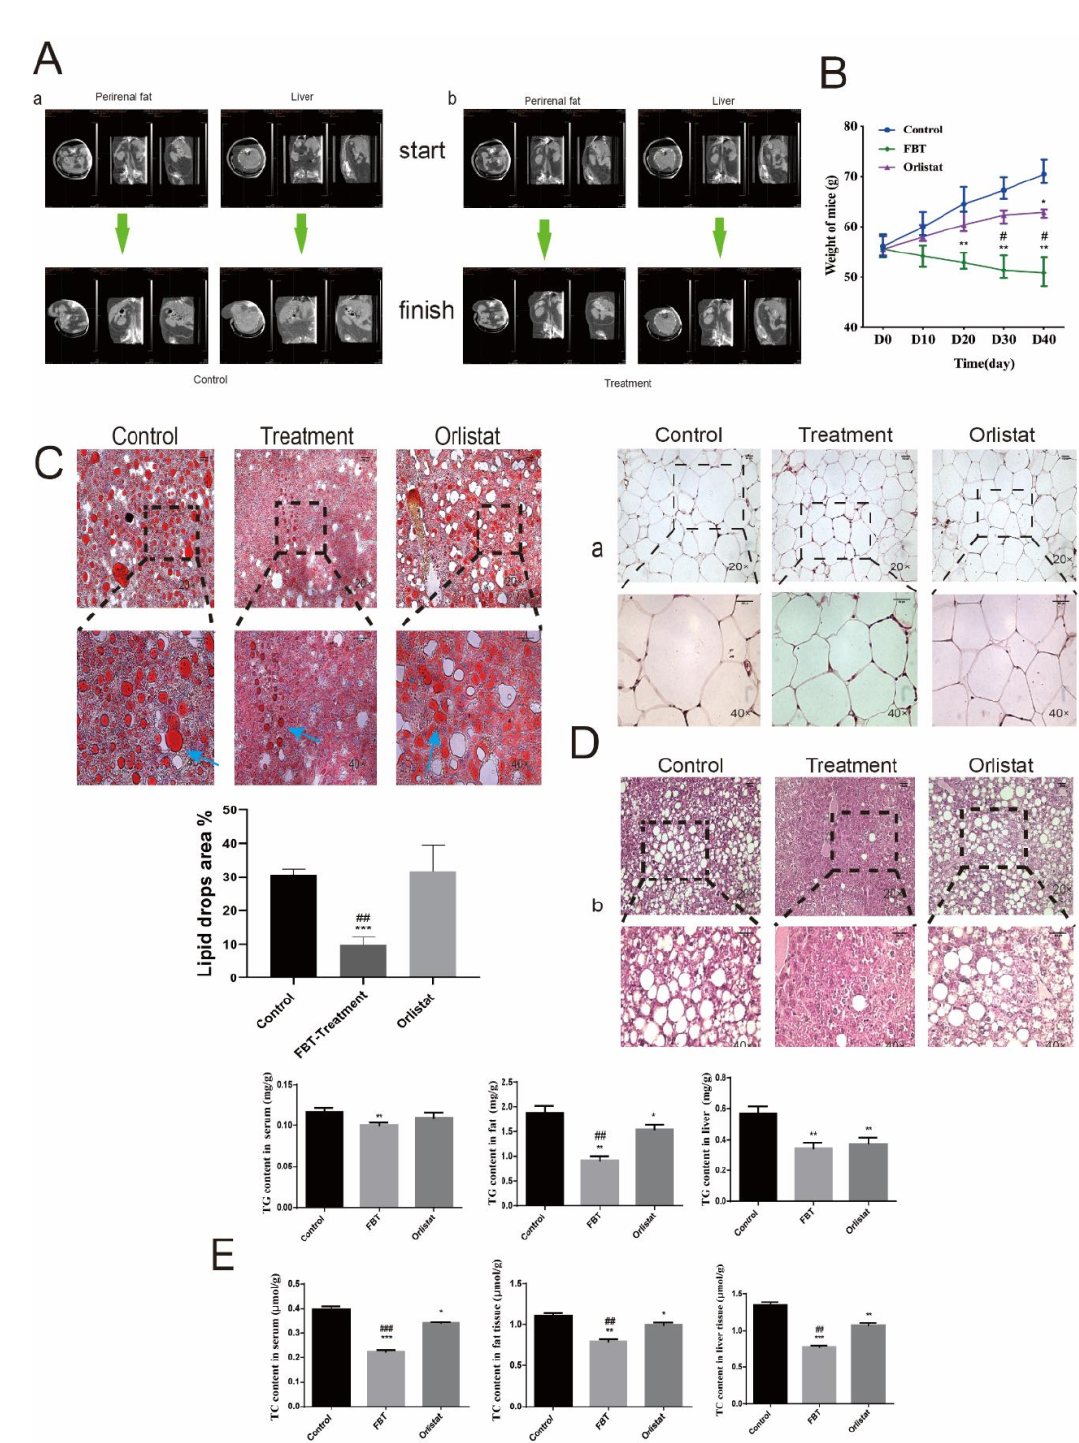
Figure 5. ( A ) Comparison of PET-CT scan results of mice before and after gavage. ( A-a ) PET-CT scan of perirenal fat and liver in the control group; ( A-b ) PET-CT scan of perirenal fat and liver in the FBT treatment group. ( B ) Weight changes in different groups over 40 days. ( C ) Frozen sections of liver were stained with Oil Red O, and the lipid droplet area was quantified using ImageJ. ( D ) HE staining of paraffin sections of mouse white adipose tissue and liver tissue ( n = 6). ( E ) The contents of TG and TC in mouse liver, white fat and serum. * p < 0.05, ** p < 0.01, and *** p < 0.0001 versus the control group; # p < 0.05, ## p < 0.01, and ### p < 0.0001 versus the orlistat